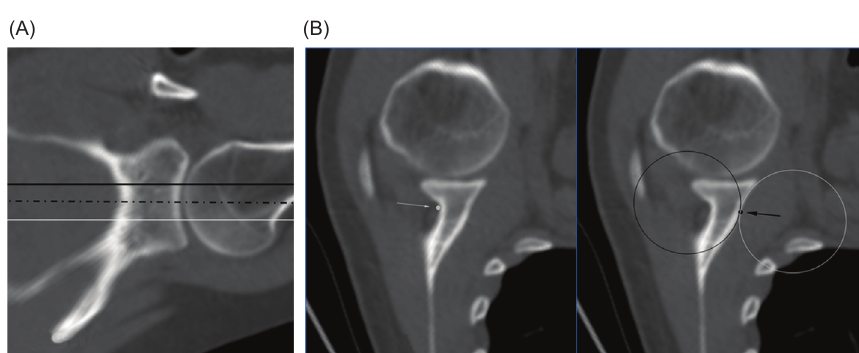
Figure 1. (A) CT imaging showing the position of the three axial cross-sections used to determine the GvOC ROI landmarks; black line ; showing the axial cross-section at the level of the superior third-middle third junction; white line ; showing the junction between the middle- third and inferior third; dotted line; showing the equatorial level of the glenoid. (B) CT imaging showing axial cross-sections of a glenoid specimen analysed with the GvOC ROI landmarks demonstrated. The left image; posterior ROI point – white arrow, white dot . The right image; The anterior slope of the glenoid is slightly curved with an anterior concavity and therefore fi ts with a sphere as demonstrated by the white sphere ; and the onset of the subscapularis fossa also has a curved shape, with a posterior concavity, that also fi ts with a sphere as demonstrated by the black sphere . The anterior ROI point – black point, black arrow – is placed at the cross-section between both spheres, that also represents the change of curvature of the anterior aspect of the glenoid vault.